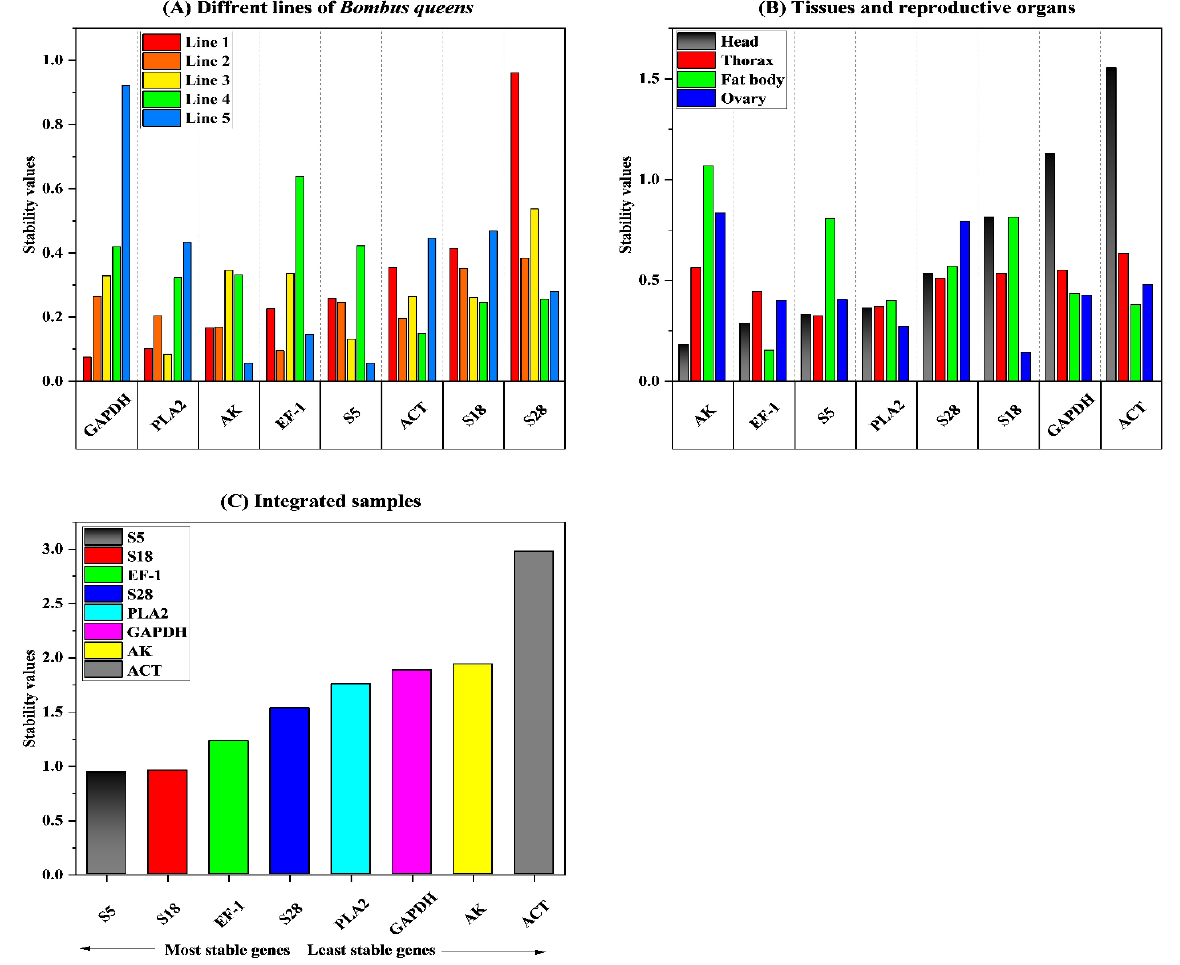
Figure 2. NormFinder was used to calculate the expression stability values of the eight candidate reference genes. The average stability values (mean values) of the bumble bee samples prepared from five different lines ( A ), the different tissue and reproductive organ types ( B ), and an integration of all samples were calculated arithmetically ( C ).